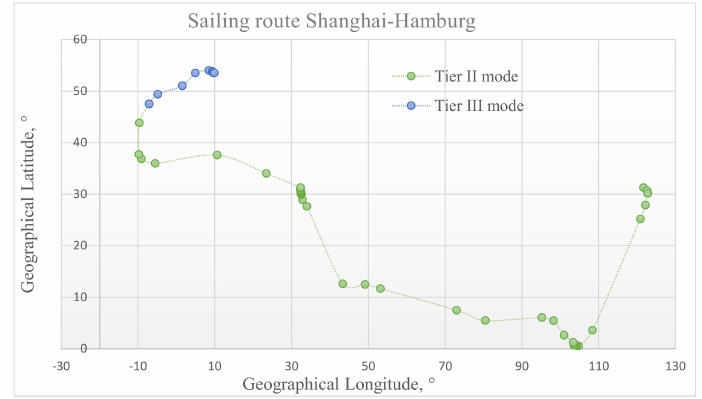
Figure 17. The sailing route connecting Shanghai port and Hamburg port.